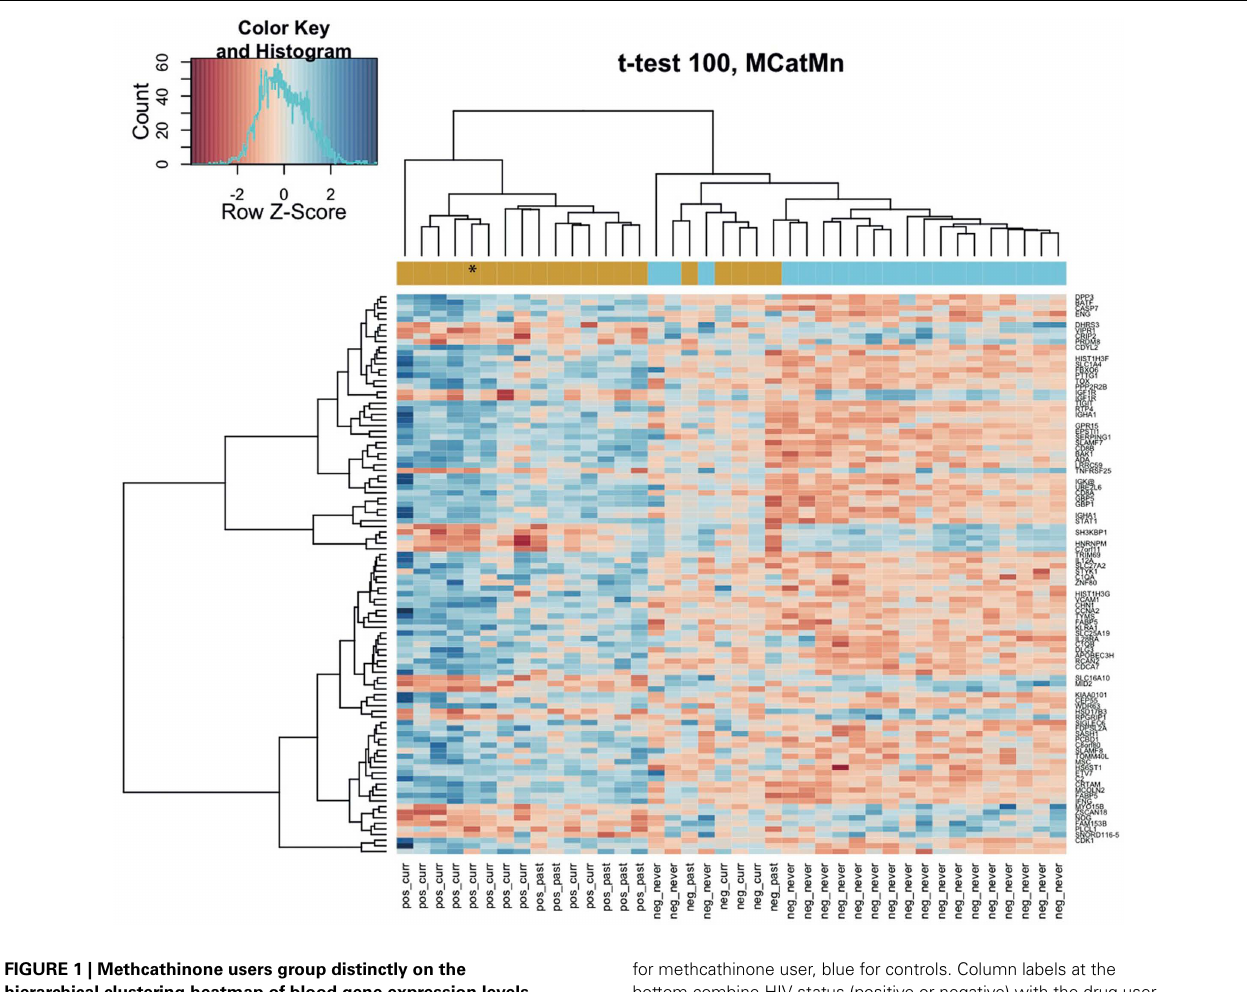
FIGURE 1 | Methcathinone users group distinctly on the hierarchical clustering heatmap of blood gene expression levels. The top 100 genes from the decreasing ordered list of moderated t -values were clustered according to similarity in their gene expression patterns. Signals are scaled to Z -scores of the rows.The colored bar above the heatmap indicates the grouping variable – goldenrod